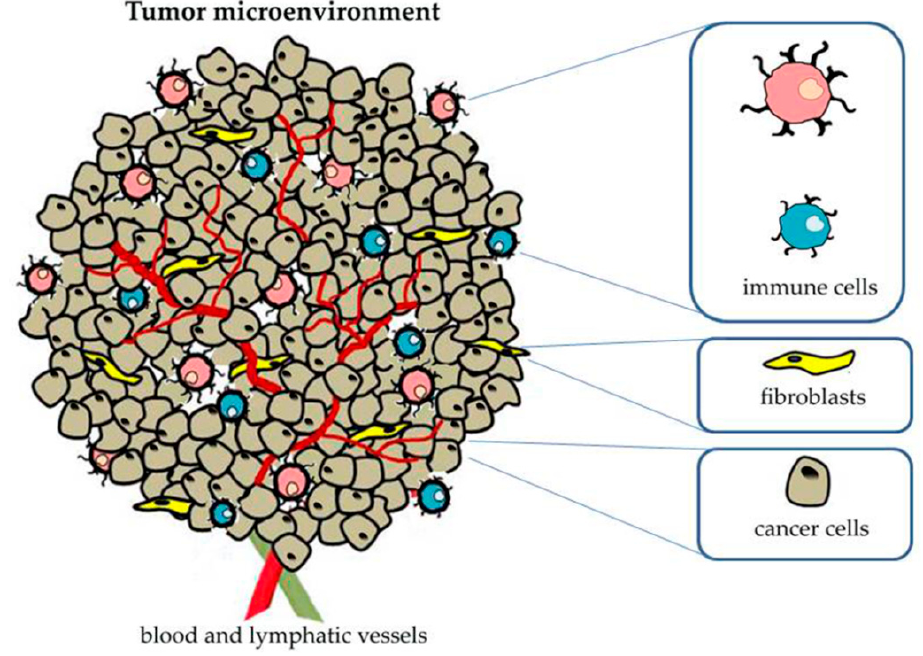
Figure 1. Schematic representation of tumor microenvironment and main associated components.